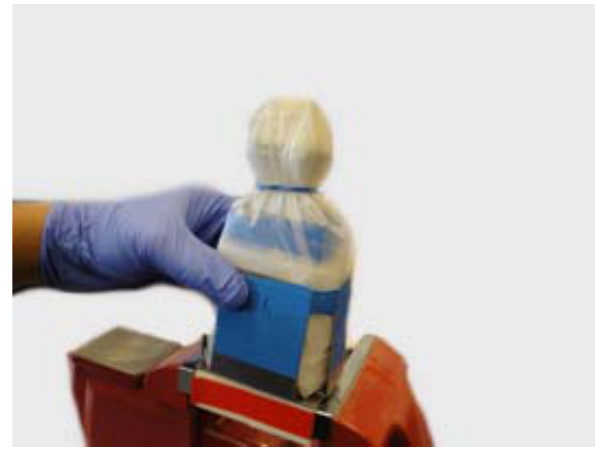
Figure 4. Initial sheath shell prototype showing its placement over a stationary probe.